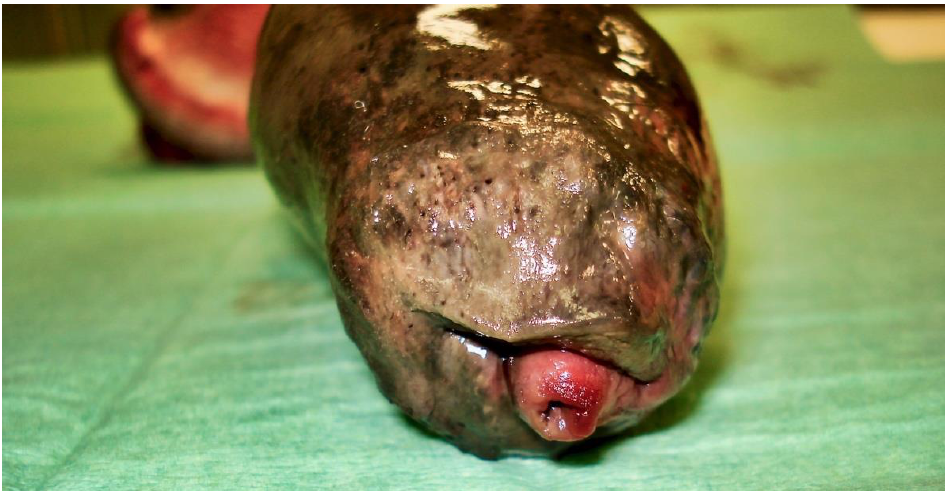
Figure 8. Necrosis at the tip of the penis.